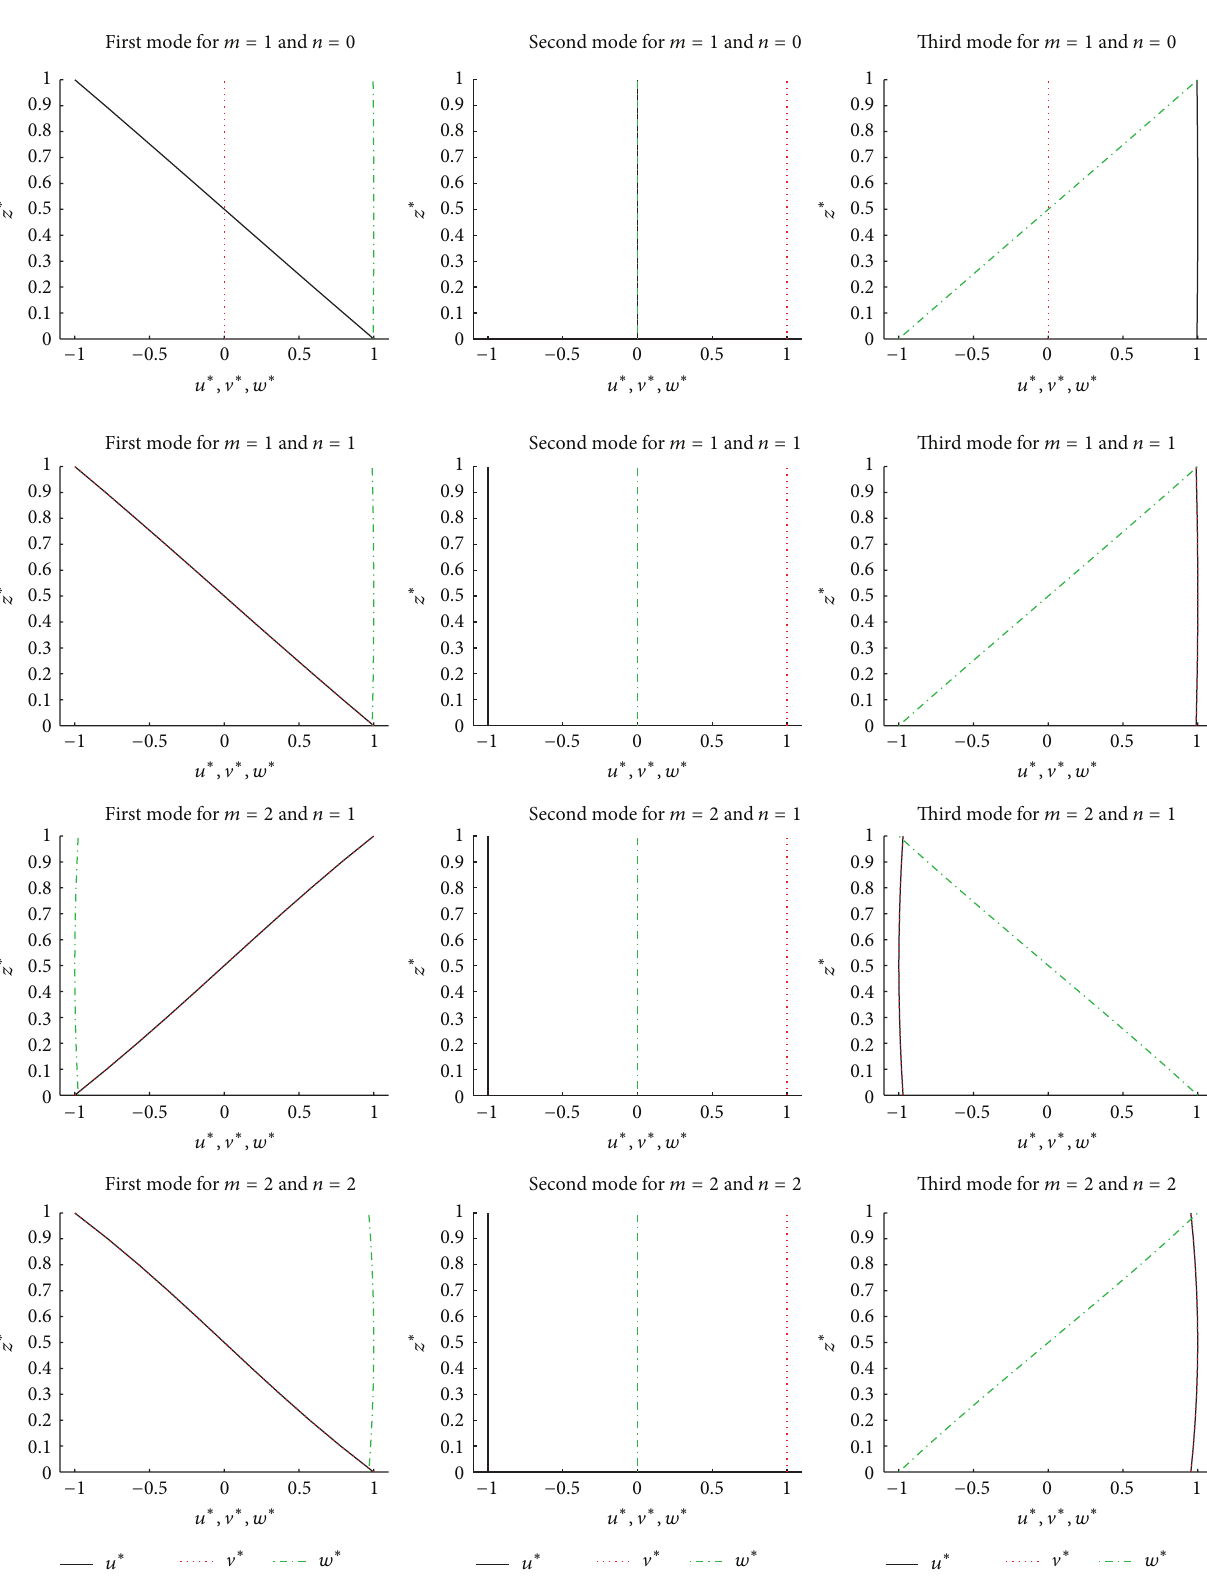
Figure 4: Benchmark 1, simply supported isotropic square plate. First three vibration modes in terms of displacement components through the thickness for thickness ratio 𝑎/ℎ = 10 and several combinations of half-wave